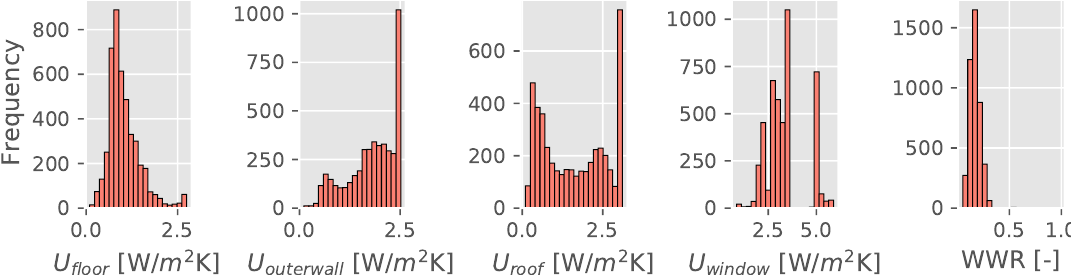
Figure 3. Five histograms showing the building parameter distribution in the nine GenkNET neighbourhoods, according to the 9 × 500 variations.